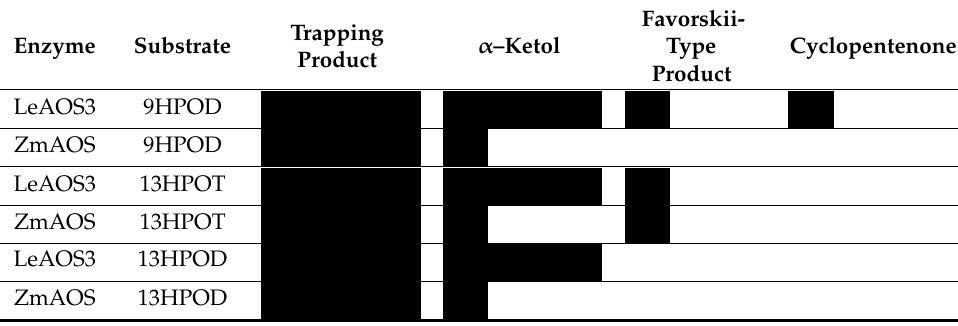
Table 3. The relative abundance of different products after the brief biphasic incubations of LeAOS3 and ZmAOS with fatty acid hydroperoxides followed by ethanol trapping. Fulfilled boxes, major products; partly filled boxes, minor products; empty boxes, undetected